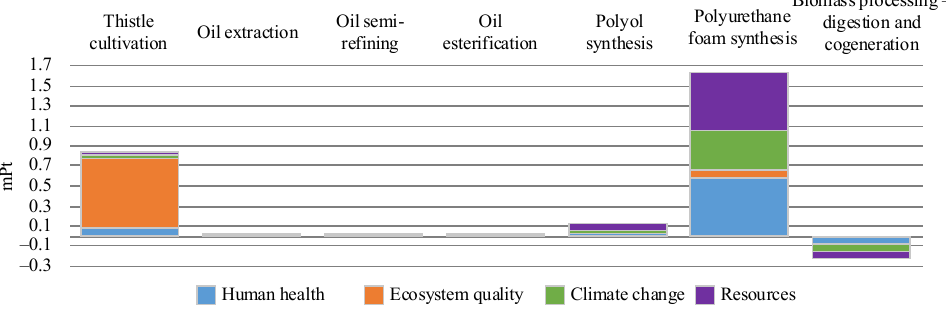
Fig. 5. IMPACT 2002+ environmental performances in ecological Point (mPt) for each steps of system for the production of 1 kg rigid polyurethane